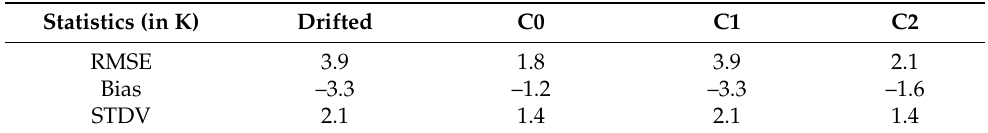
Figure 3. Time series of the drifted (continuous) and reference (dotted) time series for N07 and site 208 (coordinates 25.159 N, 22.711 E) corresponding to a desert area in eastern Libya ( a ); difference between drifted and reference time series (in black) and between corrected and reference time series (C0, C1, and C2, respectively, in red, green, and blue) for the same location and platform ( b ). Table 2. Statistics for BELMANIP site 208 for the N07 platform between drifted and reference time series as well as for each orbital drift correction method (C0, C1, and C2). STDV stands for standard